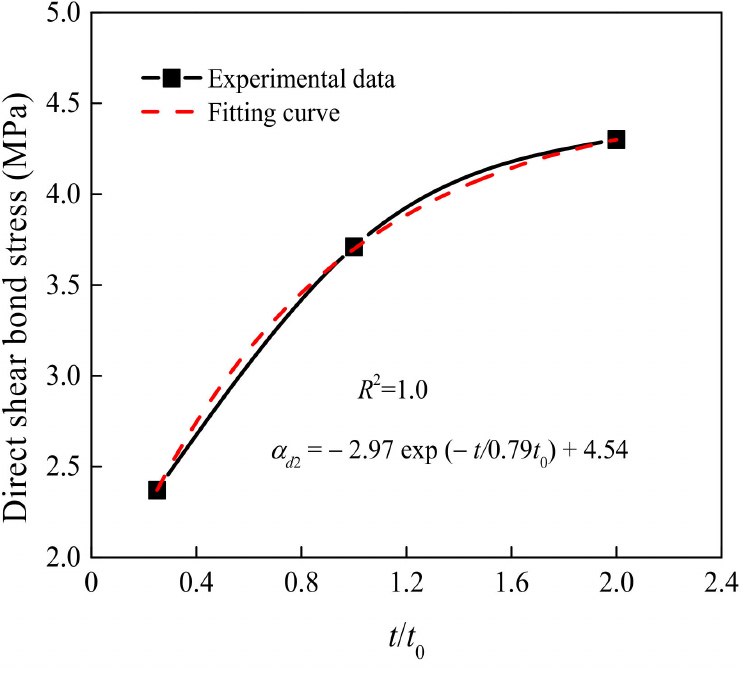
Figure 10. Effect of the ESS-HPC curing age on shear bond